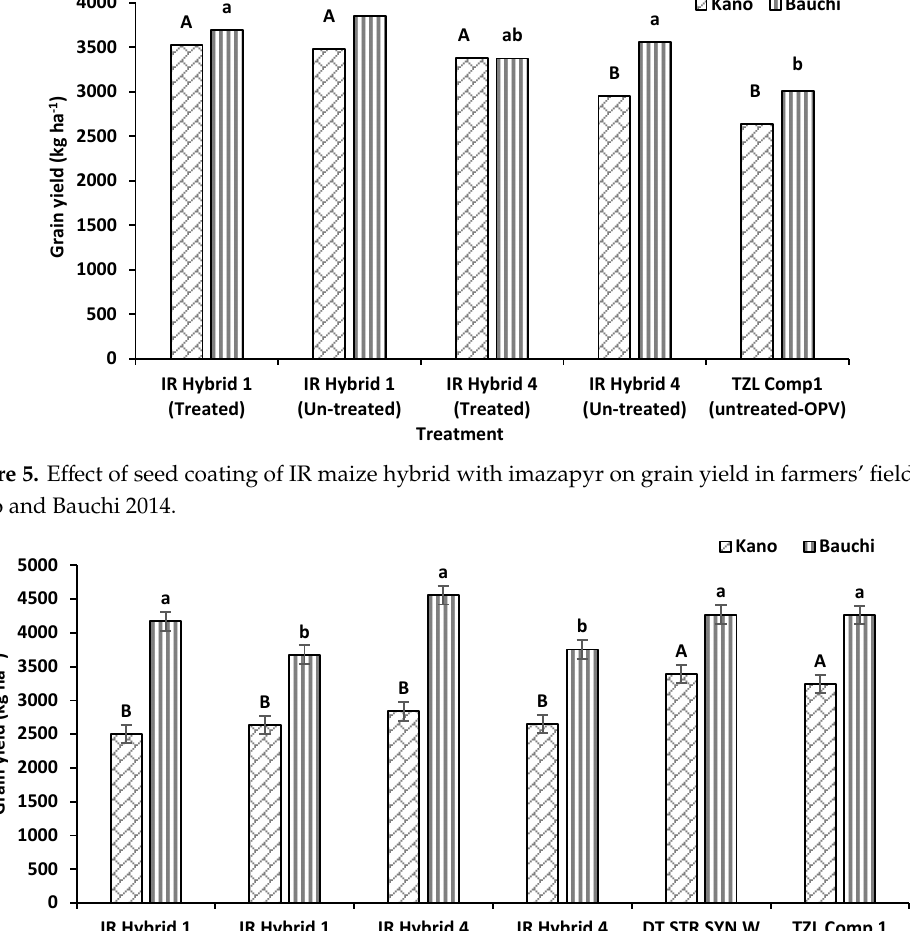
Figure 4. Host damage scores of IR maize hybrids treated with imazapyr in farmers’ fields in Kano and Bauchi 2015.